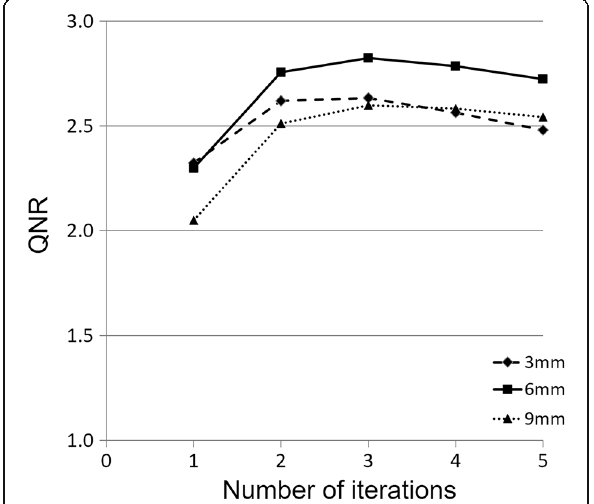
Fig. 5 Changes in the Q H,10mm to N 10mm ratio (QNR) as a function of the number of iterations for different Gaussian filters. Of the first to fifth iterations, and 3, 6, and 9 mm FWHM values for the Gaussian filters were used. The maximum QNR (2.82) was found at 3 iterations and for the 6-mm Gaussian filter